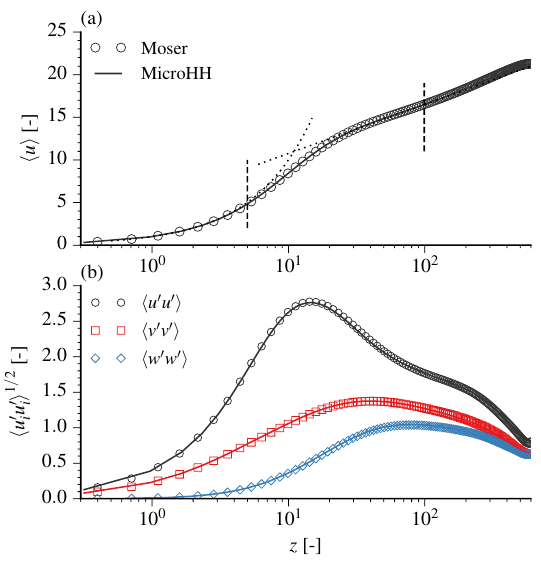
Figure 5. Velocity means (a) and variances (b) for Moser et al. (1999) channel flow case at a Reynolds τ of 590. The dashed ver- tical lines mark the spectra locations. Height z is normalized with u τ /ν ; velocities with u − 1 τ